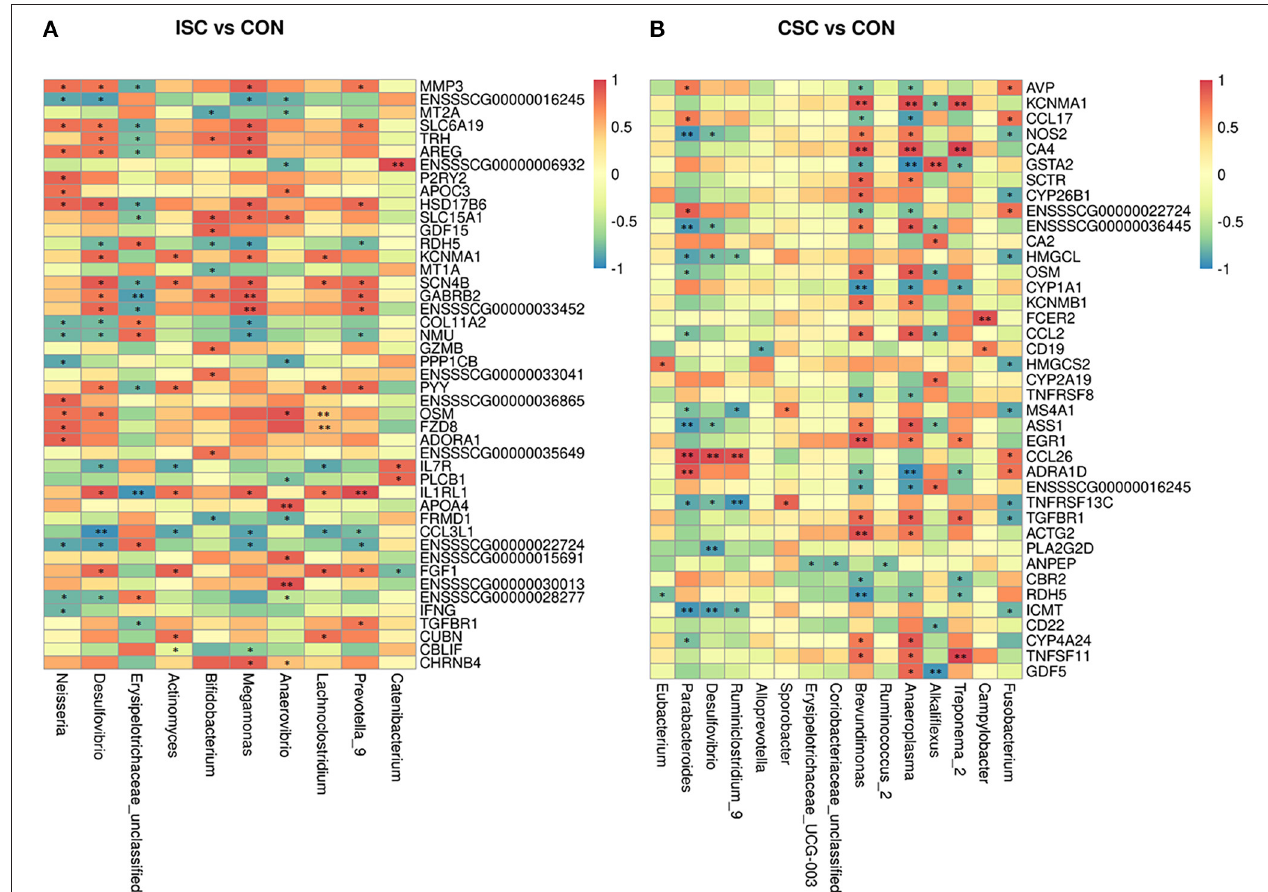
FIGURE 4 | Heat map of Spearman’s correlation coefficient between colonic differentially expressed genes and fecal microorganisms of piglets. (A) The correlation coefficient between the ISC and CON groups. (B) The correlation coefficient between the CSC and CON groups. * p < 0.05, ** p < 0.01. ISC, intermittent social contact; CSC, continuous social contact; CON,